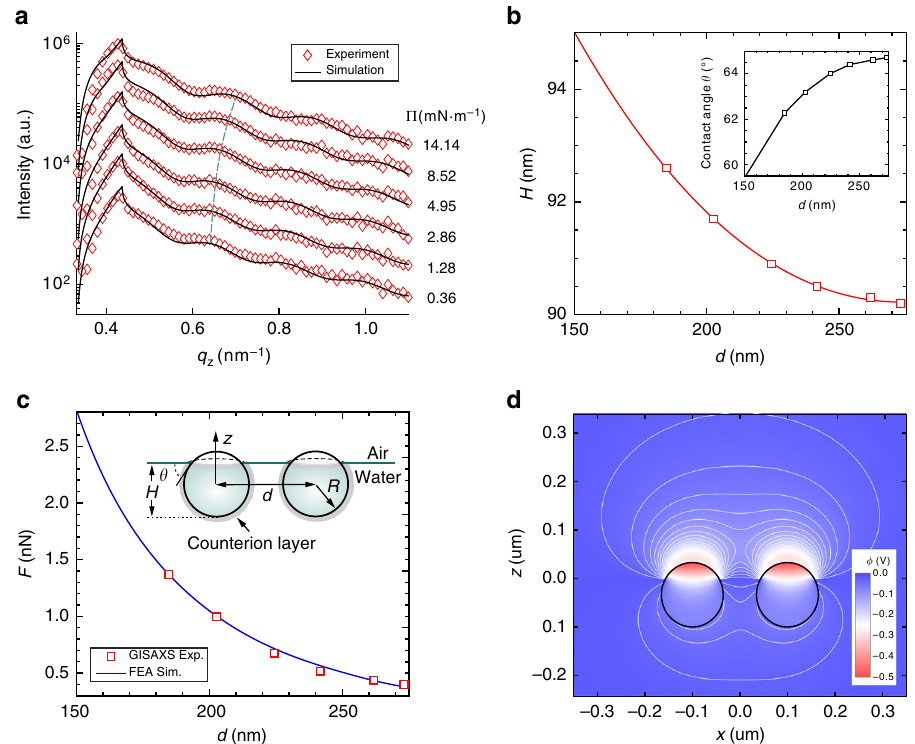
Fig. 4 Out-of-plane structures and electrostatic interactions. a The 1D X-ray scattering pro fi les extracted along the q z direction at the peak positions of the GISAXS patterns during stage II at surface pressures of 0.36, 1.28, 2.86, 4.95, 8.52, and 14.14 mN m − 1 (red diamonds). The theoretical simulations are given as black solid lines and the corresponding parameters are listed in Supplementary Table 2. b The immersion depth H and contact angle θ (inset) plotted as functions of the interparticle distance d . The lines are the polynomial fi ttings to the data as guides to the eye. c The magnitude of the out-of-plane component of the electrostatic fore plotted as a function of d . The electrostatic forces are estimated from surface tension analyses (red squares) and the numerical simulation results are obtained from FEA (blue line). Inset: schematic illustration of a pair of PNSs at the air/water interface with all the relevant parameters shown. d The electrostatic potential distribution of a pair of PNSs at the air/water interface with the equipotential lines displayed in white. The simulation is carried out using the same set of parameters as given in Supplementary Note 4. The colloidal particles (solid circles) have the radius R = 63.2 nm, the immersion depth H = 91.7 nm, and their separation d = 200